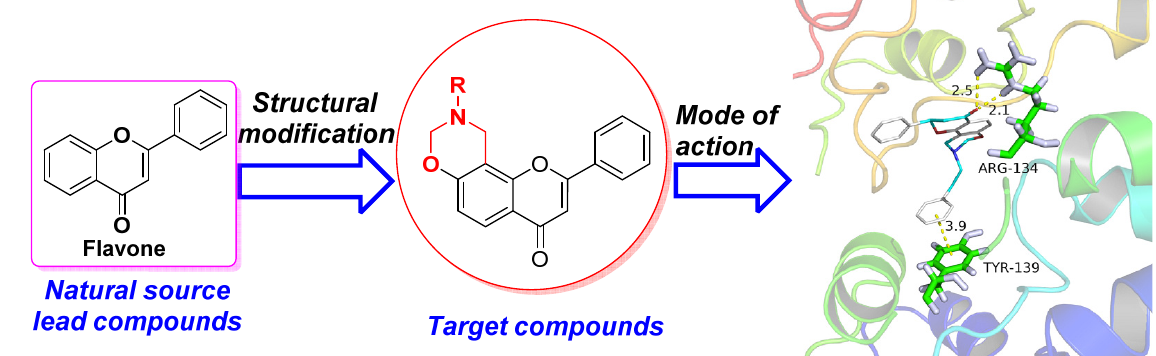
Figure 1. Design of flavonoids containing the oxazine structure.